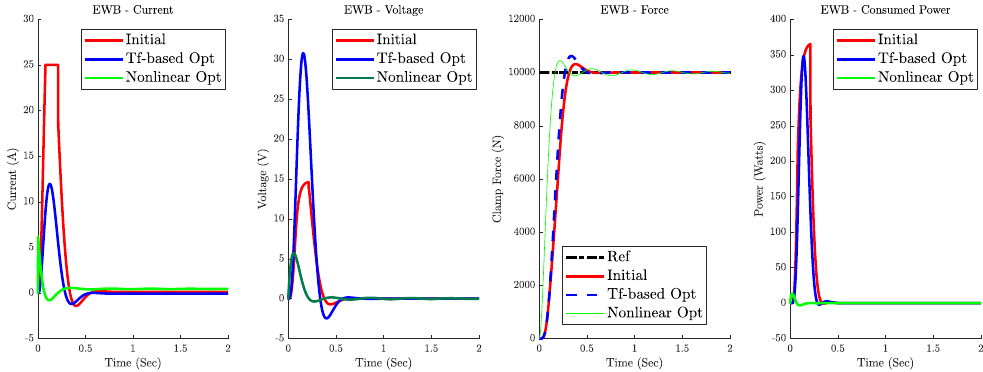
Figure 10. Comparison of the initial parameter sets vs. optimized in an EWB for a 10 kN step input. The clamp force plot for the initial parameter setting was consistent with Che Hassan et al. [12]. The optimized results are the novelty of this paper.